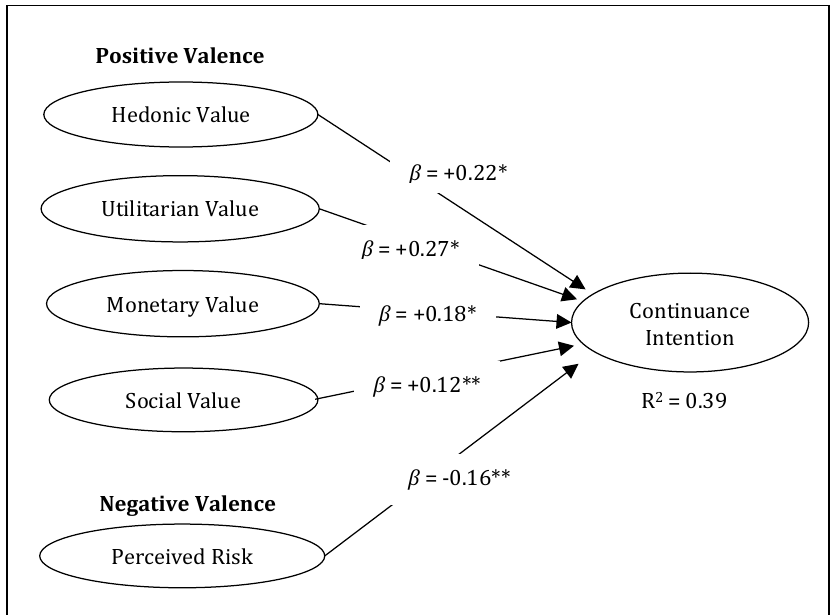
Figure 2: Path Coefficients for Continuance